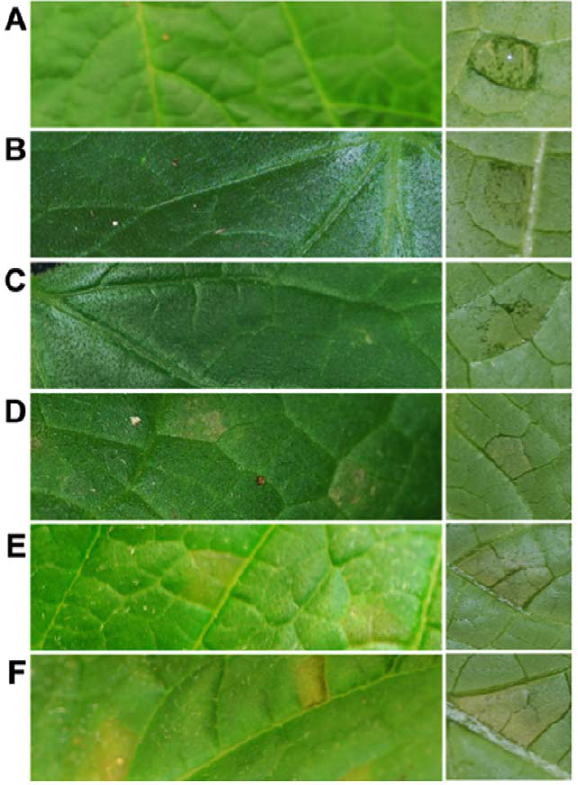
Figure 1. Symptoms of Pseudoperonosporacubensis infection on susceptible Cucumissativus cv. ‘Vlaspik’. Images were collected of the adaxial (left column) and abaxial (right column) leaf surfaces at 1, 2, 3, 4, 6, and 8 days post-inoculation (dpi). A ., 1 dpi, B ., 2 dpi, C ., 3 dpi, D ., 4 dpi, E ., 6 dpi, F ., 8 dpi.